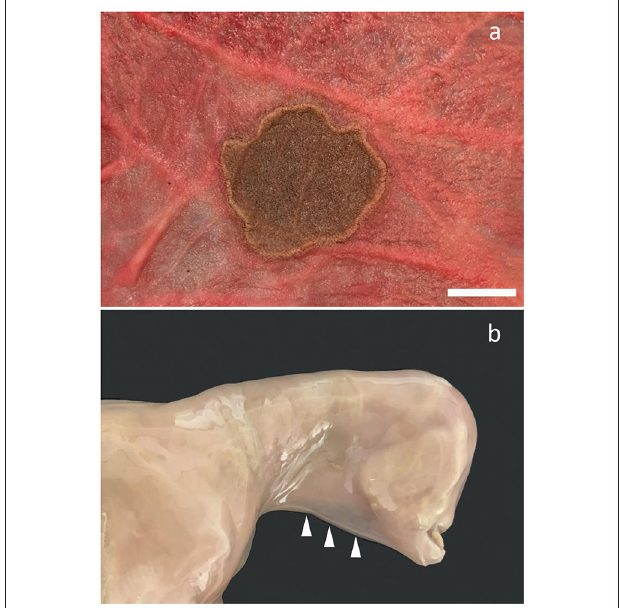
FIGURE 5 | Other sporadic conditions found. (a) Localized necrosis in the allantochorion. Fetus aborted at gestation day 231. Bar = 2.5cm; (b) Fetus aborted at gestation day 122. Notice anophthalmia, absence of pinna, superior brachygnathism, and the presence of a connective tissue band at the ventral midline of the head and neck